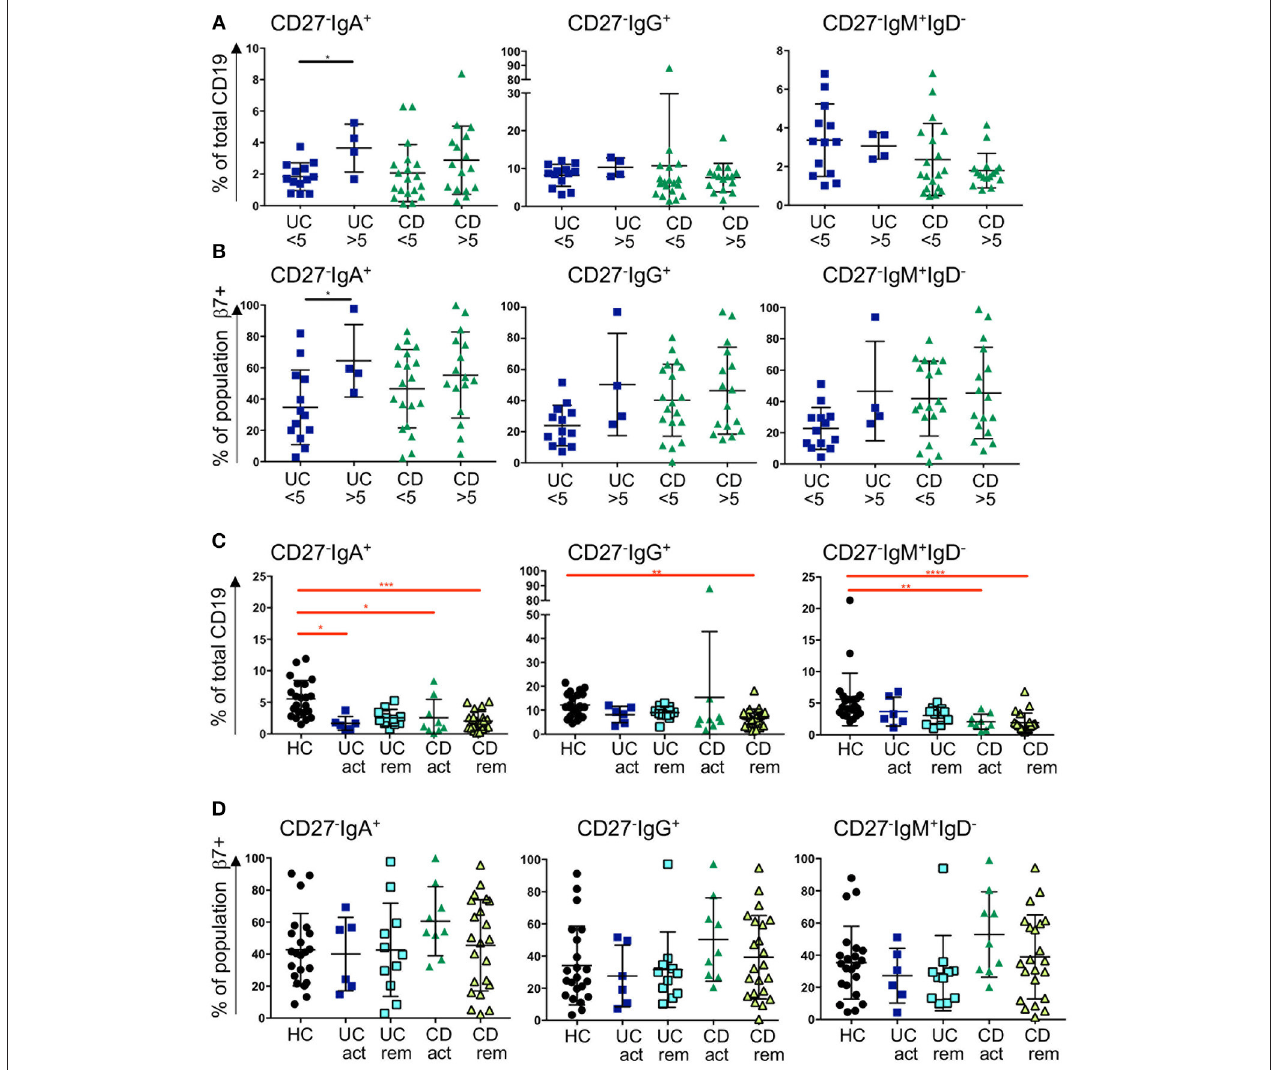
FIGURE 4 | Frequency of blood CD27 − IgD − subsets and β 7 integrin expression in CD and UC patients stratified according to CRP levels and remission status. Three subsets of CD27 − IgD − B cells (CD27 − IgA + , CD27 − IgG + , and CD27 − IgM + ) are presented as percentage of CD19 positive cells in (A) and in (B) the percentage of individual populations expressing of β 7 integrin. For (A,B) , UC < 5 n = 13, UC > 5 n = 4, CD < 5 n = 19, CD > 5 n = 16; for (C,D) HC n = 22, UC active n = 6, UC remission n = 11, CD active n = 9 and CD remission n = 22. Data is analyzed by Mann-Whitney U test (black bars and asterisks) or Kruskal-Wallis ANOVA test (red bars and asterisks) where p < 0.05 = *, p < 0.01 = **, p < 0.001 = *** and p < 0.0001 =